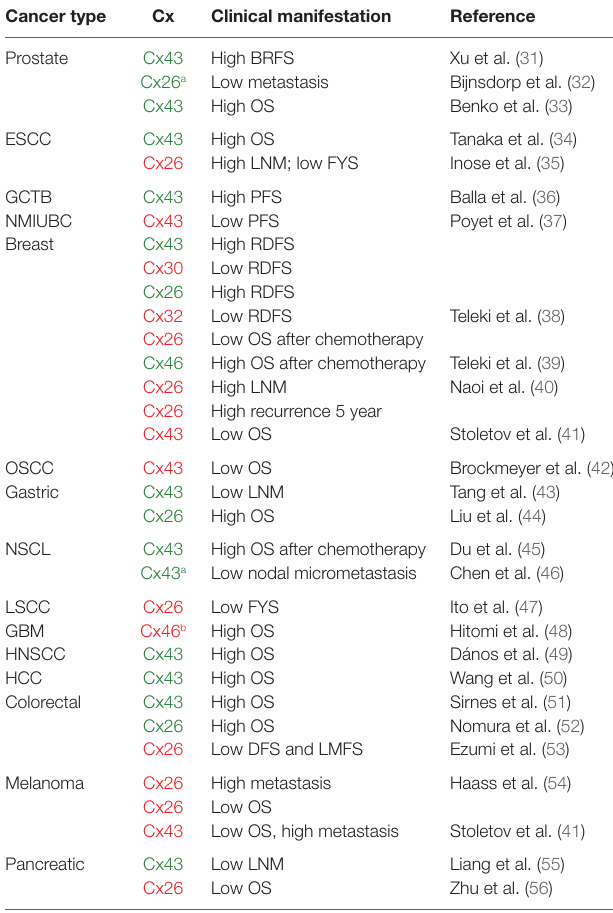
Table 1 | Associations between connexin (Cx) expression in tumors and clinical outcome in cancer